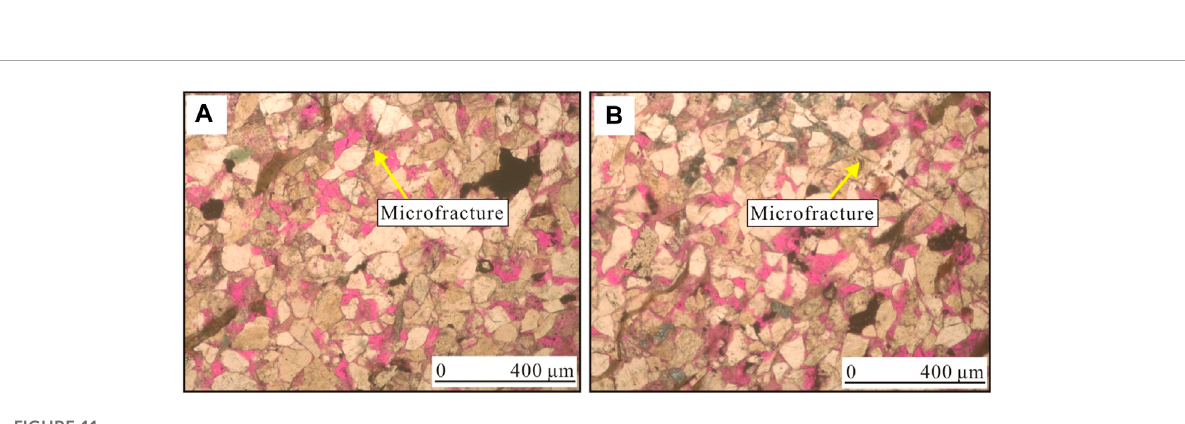
FIGURE 11 Development characteristics of micro-fractures in sandstone of the Chang 1 Member in the study area. Well Nan 141. (A) 521.97 m; (B) 522.07